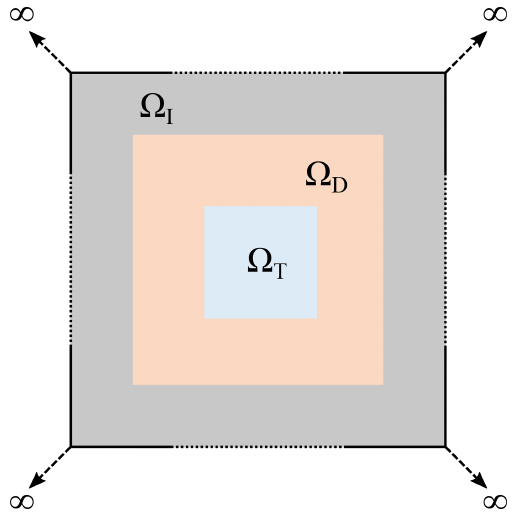
Figure 1. Sketch of the computational domain for the topology op- timization of the magnetic lens. The domain in light blue represents the target domain ( (cid:127) T ), where the magnetic field was focused. The focusing of the magnetic field was achieved by the material interpo- lation between Cu, and air in the design domain ( (cid:127) D ) is represented in orange. (cid:127) D was enclosed by an infinite-element domain ( (cid:127) I ) in grey. The entire computational domain was (cid:127) = (cid:127) T ∪ (cid:127) D ∪ (cid:127) I . (cid:127) was truncated by imposing magnetic insulation boundary condi- tions on its boundaries ( ∂(cid:127)